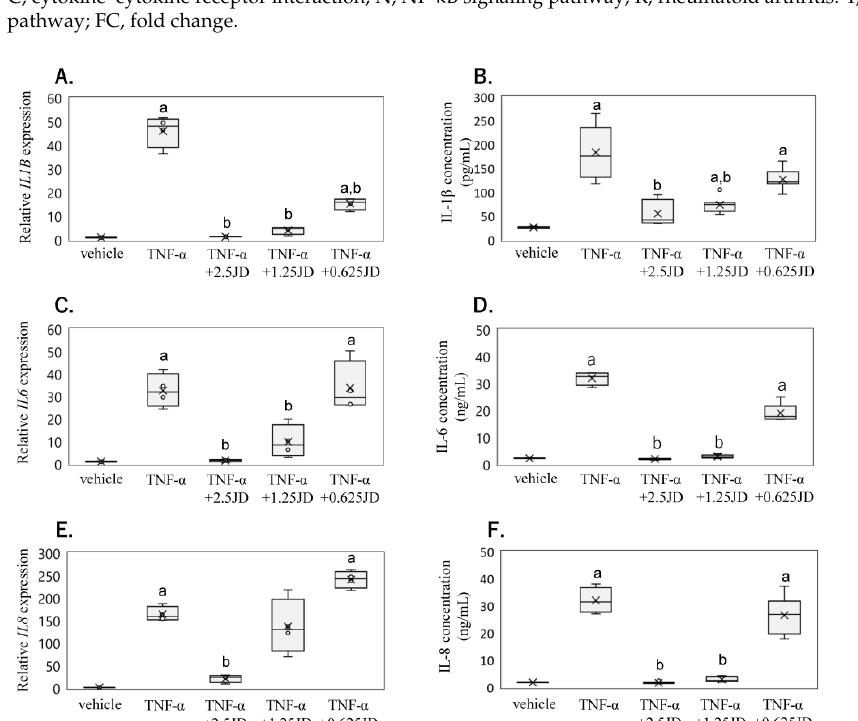
Figure 3. Effect of jietacin derivative on inflammatory cytokine expression and production in human primary synovial fibroblasts. IL1B ( A ), IL6 ( B ), IL8 ( C ) mRNA by qPCR, and IL-1 β ( D ), IL-6 ( E ), IL- 8 ( F ) protein concentration by ELISA. Human primary synovial fibroblasts stimulated with DMEM (vehicle), TNF- α, or TNF - α + jietacin derivative. a p < 0.05 compared to vehicle, b p < 0.05 compared to TNF- α .